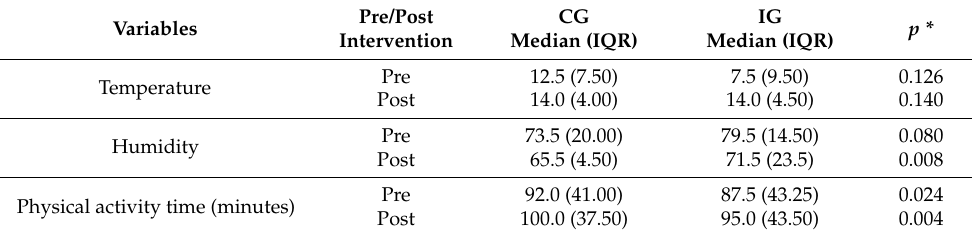
Table 2. Pre- and post-intervention median values for temperature, humidity, and physical activity time for the CG ( n = 128) and the IG ( n = 131), and the differences between the groups.